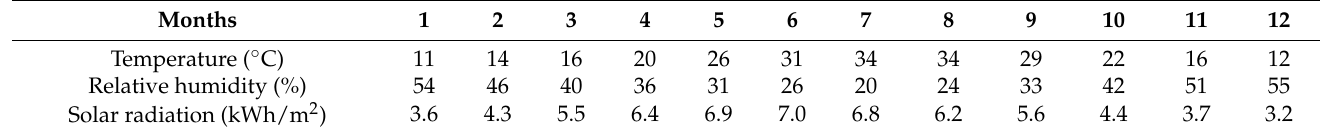
Table 1. Monthly dry bulb temperature, solar radiation, and relative humidity, average 10 years.